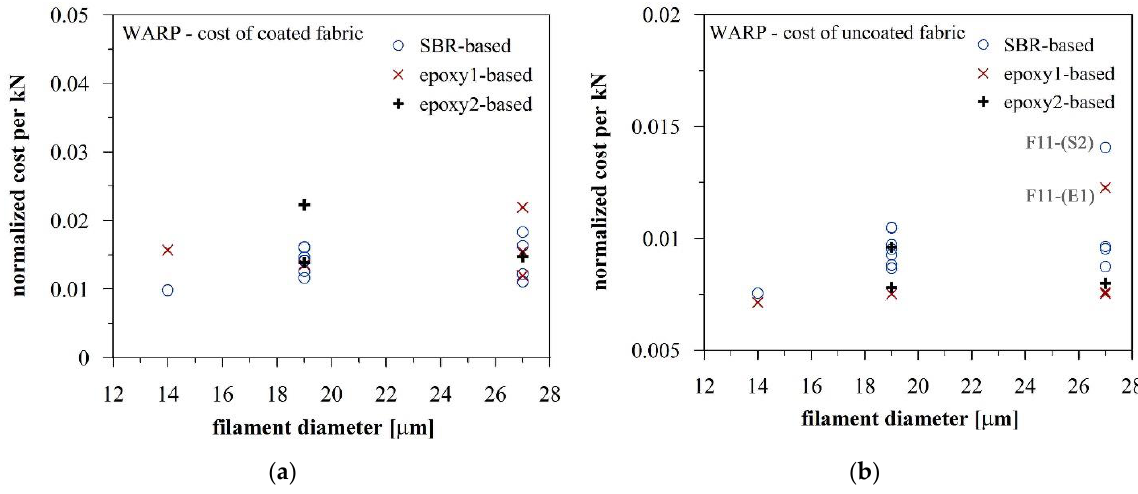
Figure 9. Normalized cost per kN vs. filament diameters: cost of the coated ( a ) and of the uncoated fabrics ( b ).